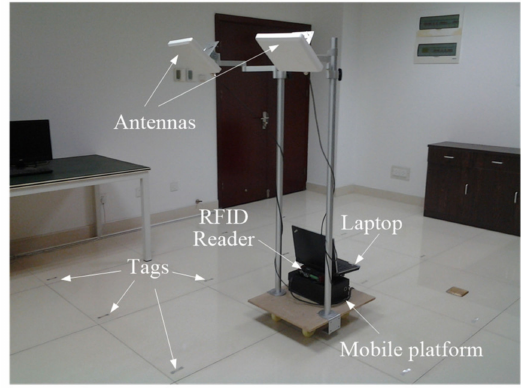
Figure 9. The indoor positioning system.